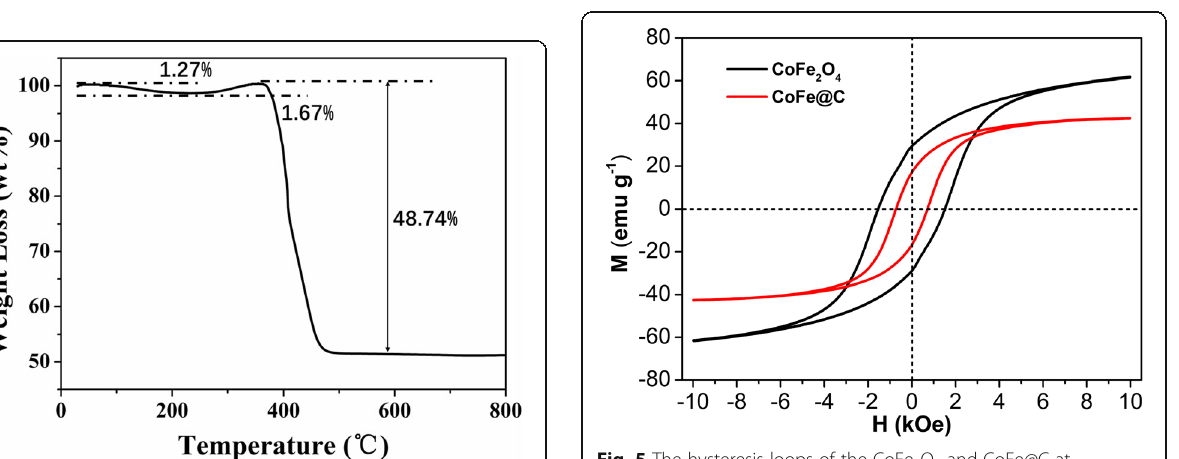
Fig. 5 The hysteresis loops of the CoFe 2 O 4 and CoFe@C at room